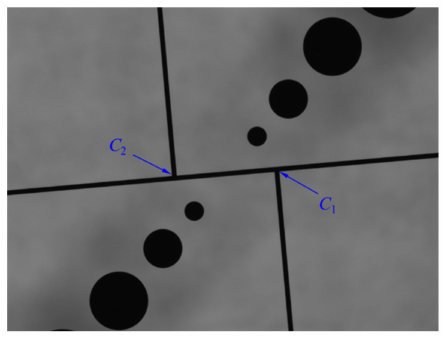
Figure 10. The captured template image at 2 × magnification.